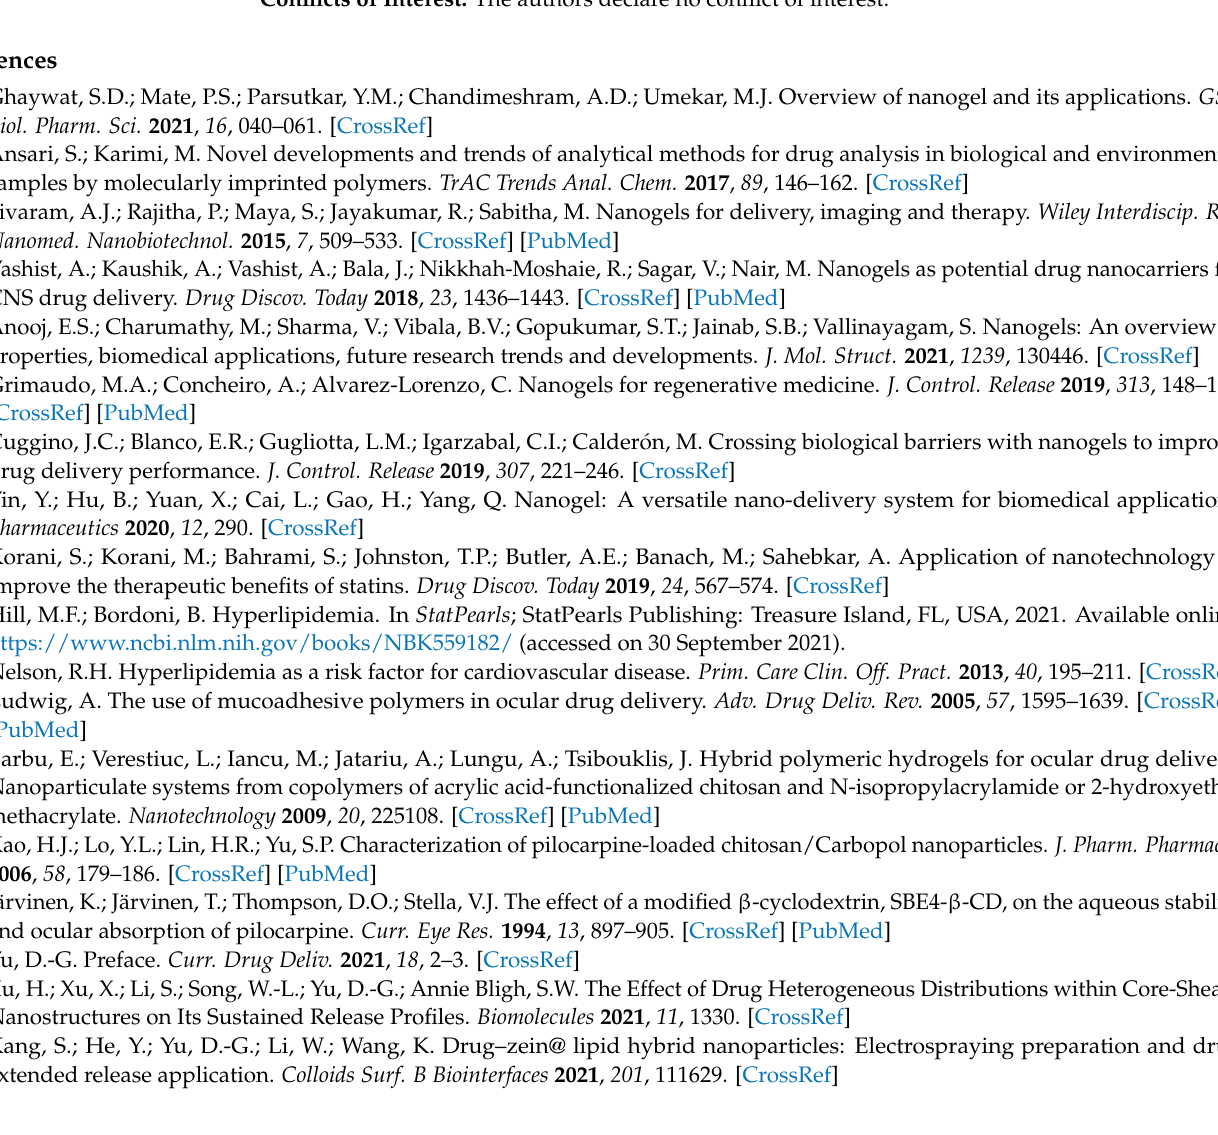
Figure S3: FTIR Spectrum of pravastatin sodium, Figure S4: Characteristics peaks of compatibility study, Figure S5: HPLC chromatogram of pravastatin